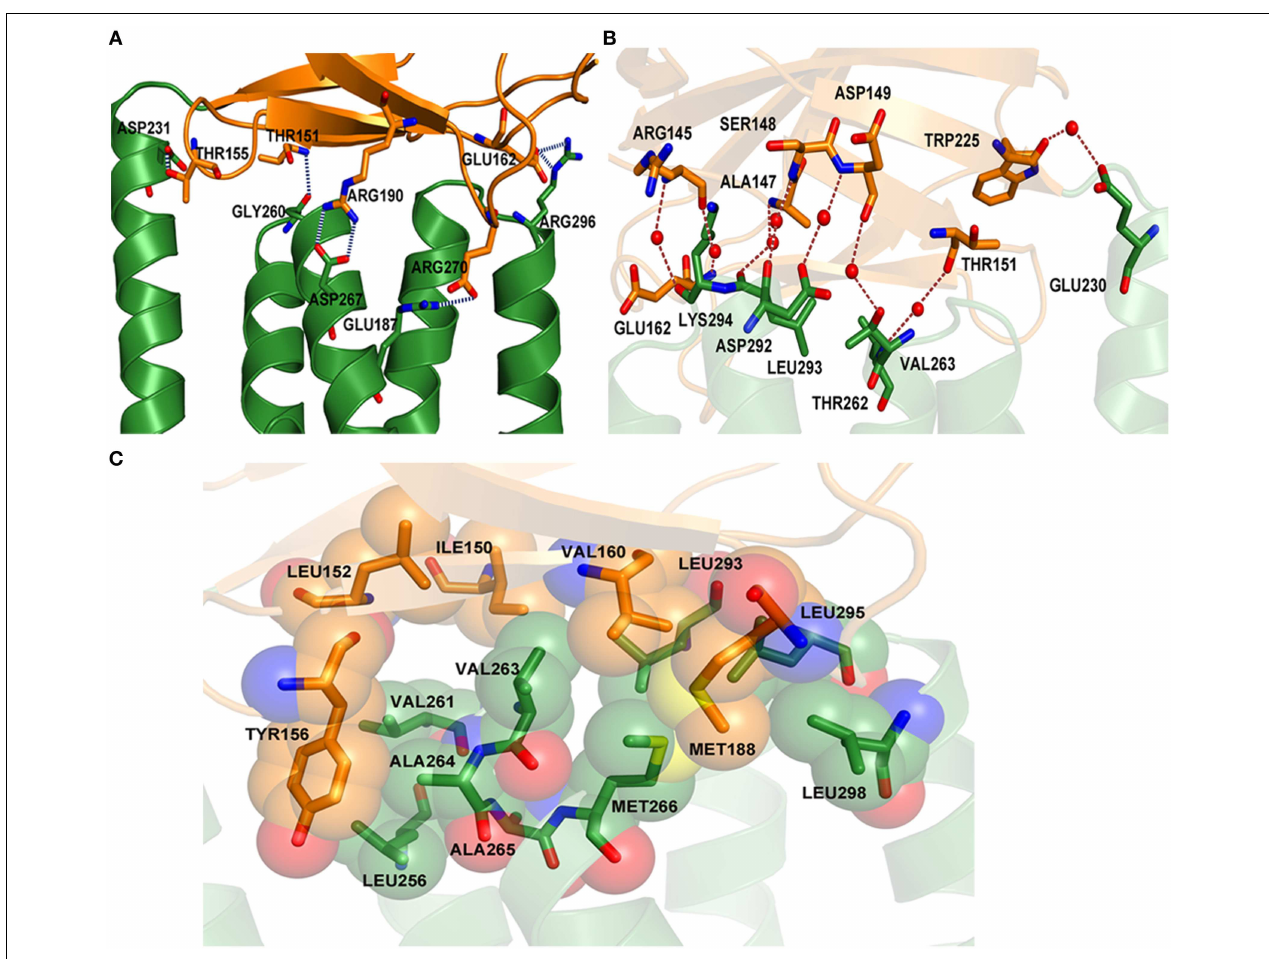
Overview of water-mediated interactions (red dotted lines) between the side chains (shown as sticks) and water (red spheres): R145 with K294, R145 with E162, A147 with L293, S148 with D292, D149 with D292, D149 with T262, T151 with V263, and W225 with E230. (C) Surface representation of hydrophobic interacting residues (shown as sticks and